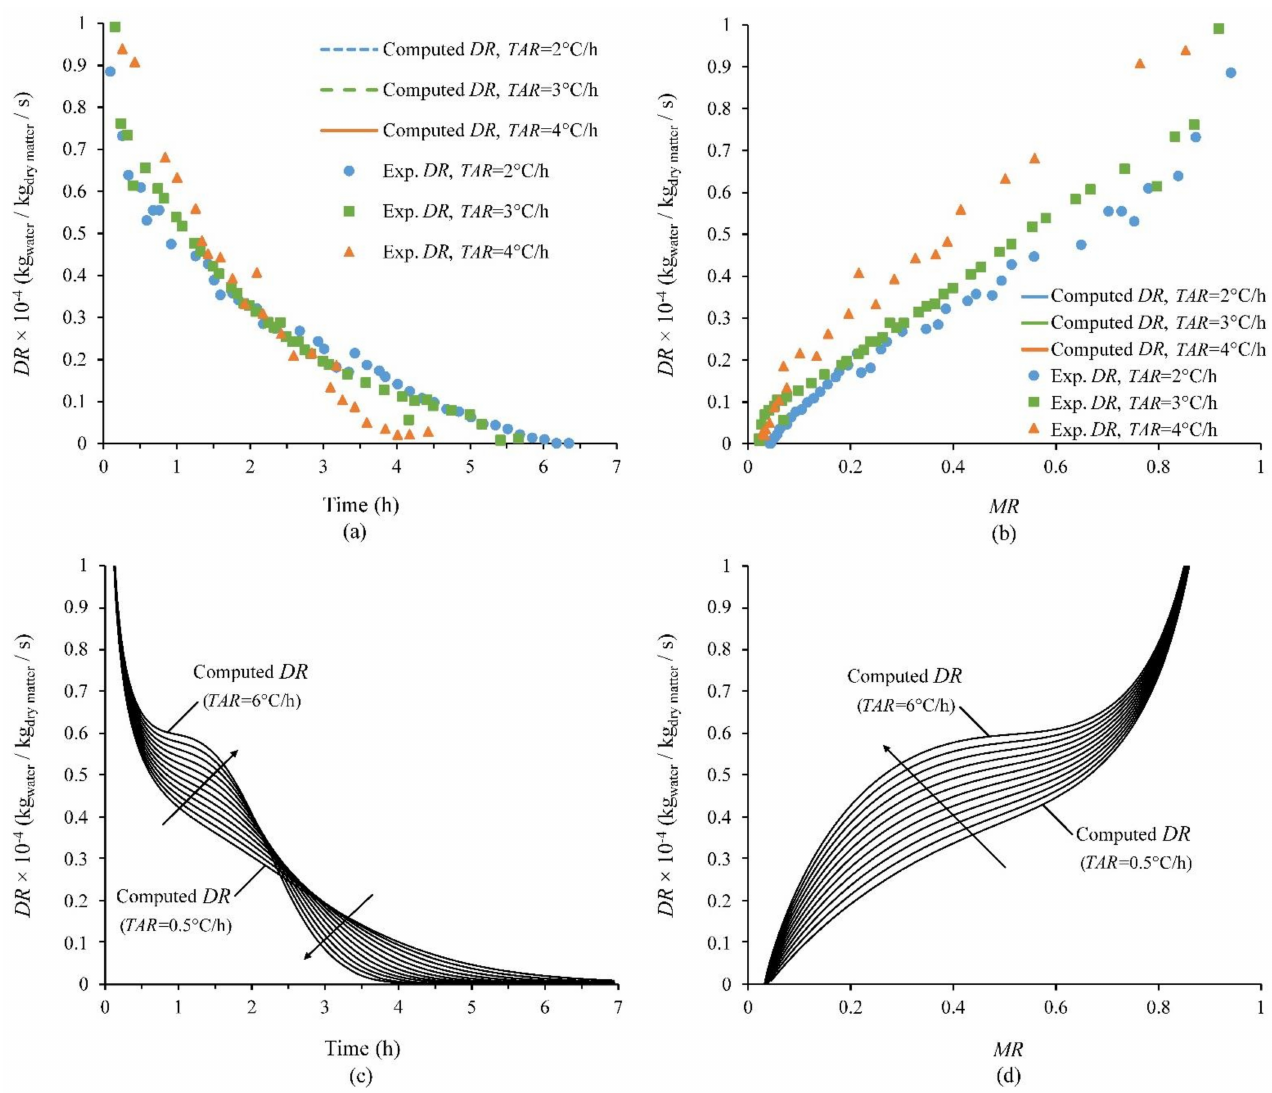
Figure 4. Measured and computed drying rate ( DR ) of lavender versus time ( a , c ) and moisture ratio ( MR ) ( b , d ) at 2